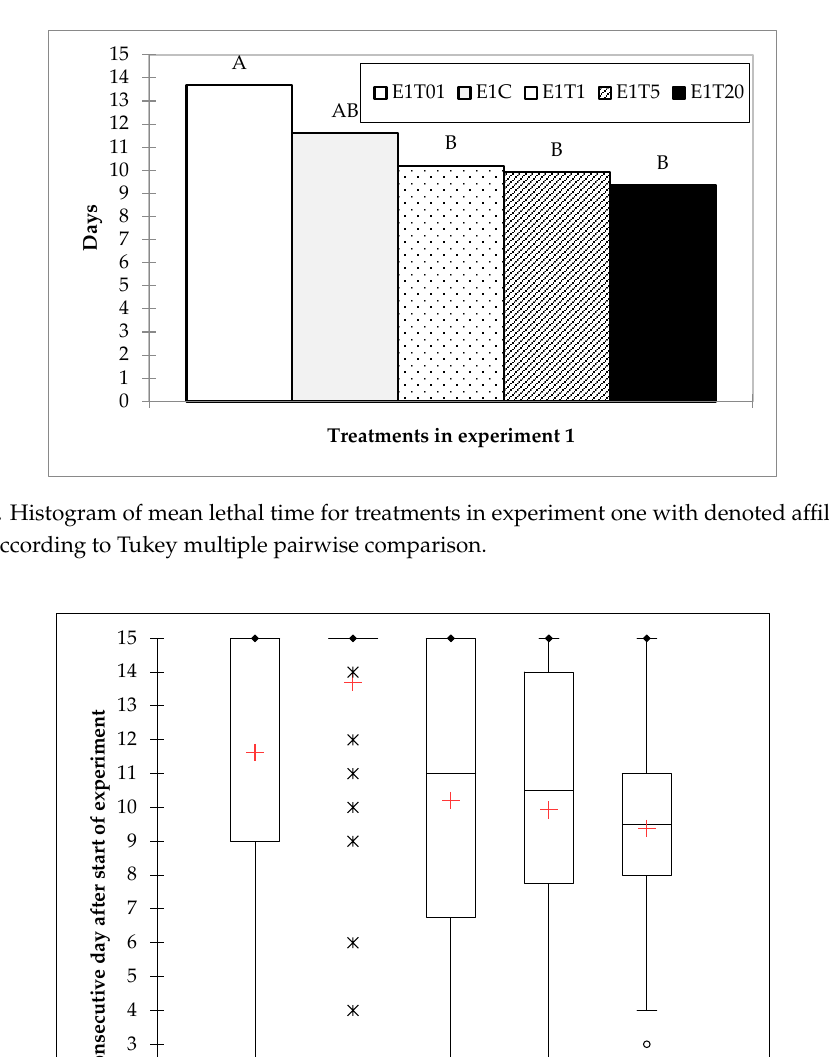
Figure 3. Box plots histograms of lethal time observed for different treatments in experiment one. Twenty μL treatment showed the lowest mean and dissipation of data, followed by 5 μL and 1 μL, while the 1:100 dilution showed highest value, even higher than the control group. Cross represents the arithmetic mean, central line of the box represents the median, upper line of the box represents the third quartile, lower line of the box represents the first quartile, outreaching lines represent standard deviations, dots represent outlayers.